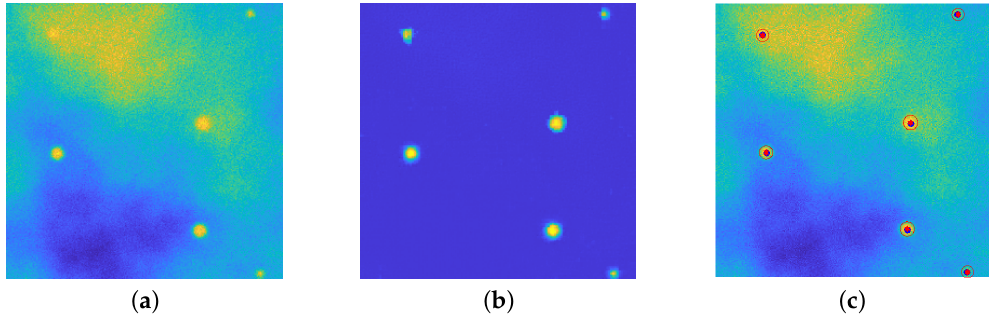
Figure 10. Particle Estimation task. ( a ): original image. ( b ): recovered image by upU-net. ( c ): su- perposition of the true particles’ center (blue dots), of the estimated center (red dots) and of the estimated profile (red lines). The values range in the interval [ 0,255 ] . In this situation one has several particles that are easily recognizable, a faint one (in the top right corner) and a last bead inside a diffuse emission area (top left